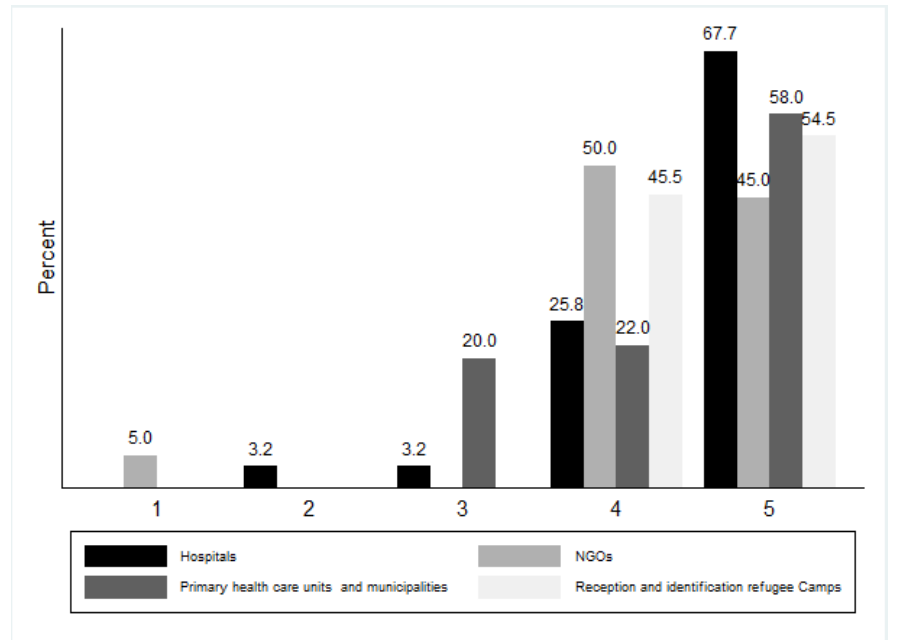
Figure 1. For Module 1 degree of agreement with the phrase “Presents the situation in a complete way” by work experience and profile.